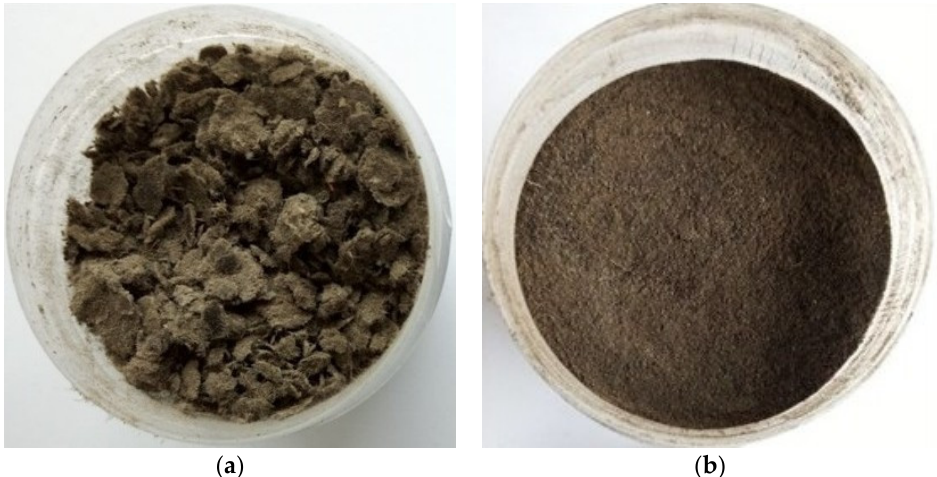
Figure 1. The ( a ) primary and ( b ) dewatered sludge after grinding and/or sieving.